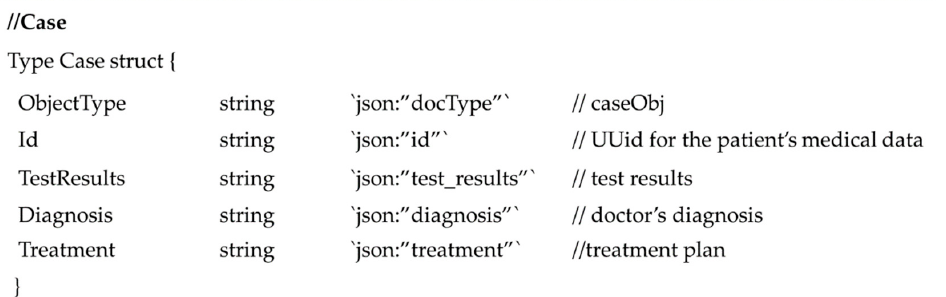
Figure 5. Data type of Case.